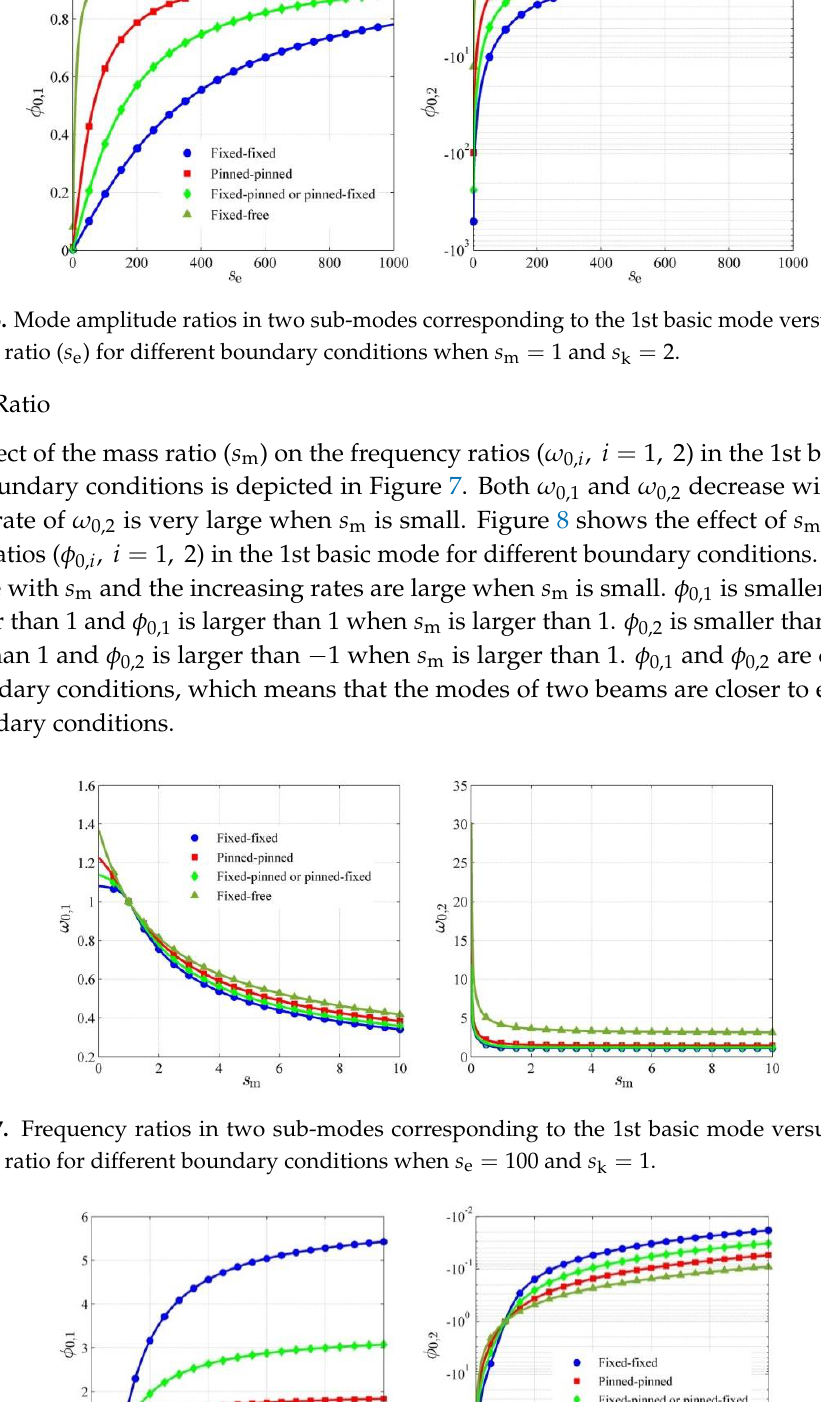
Figure 5. Frequency ratios in two sub-modes corresponding to the 1st basic mode versus contact stiffness ratio ( 𝑠 e ) for different boundary conditions when 𝑠 m = 1 and 𝑠 k = 2 .